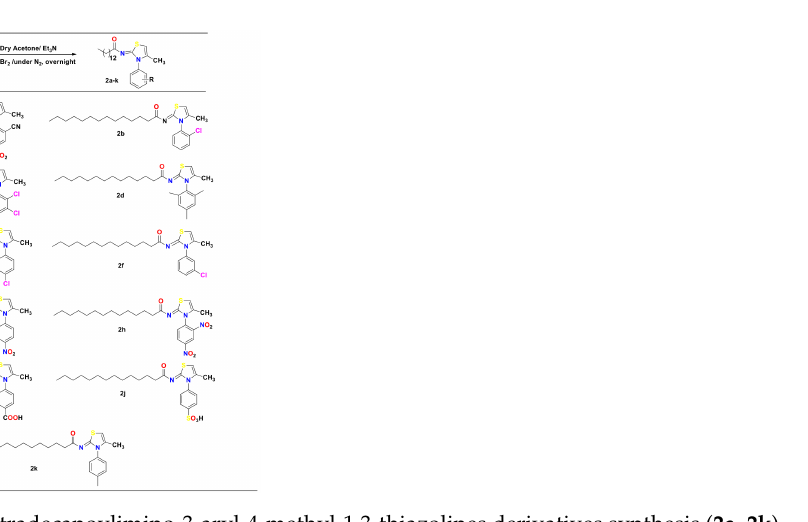
Figure 2. 2-Tetradecanoylimino-3-aryl-4-methyl-1,3-thiazolines derivatives synthesis ( 2a – 2k